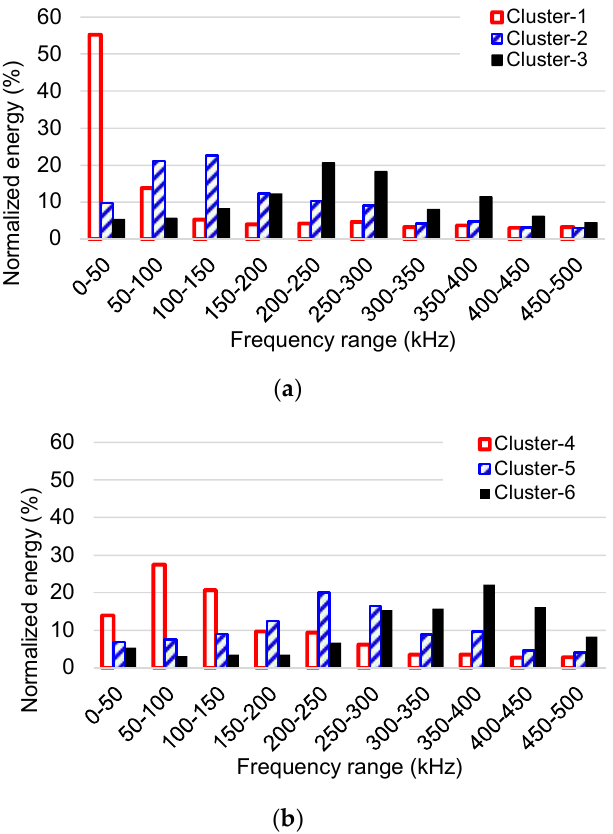
Figure 9. Average normalized signal energy in frequency domain. ( a ) Confined specimen; ( b ) Unconfined specimen.